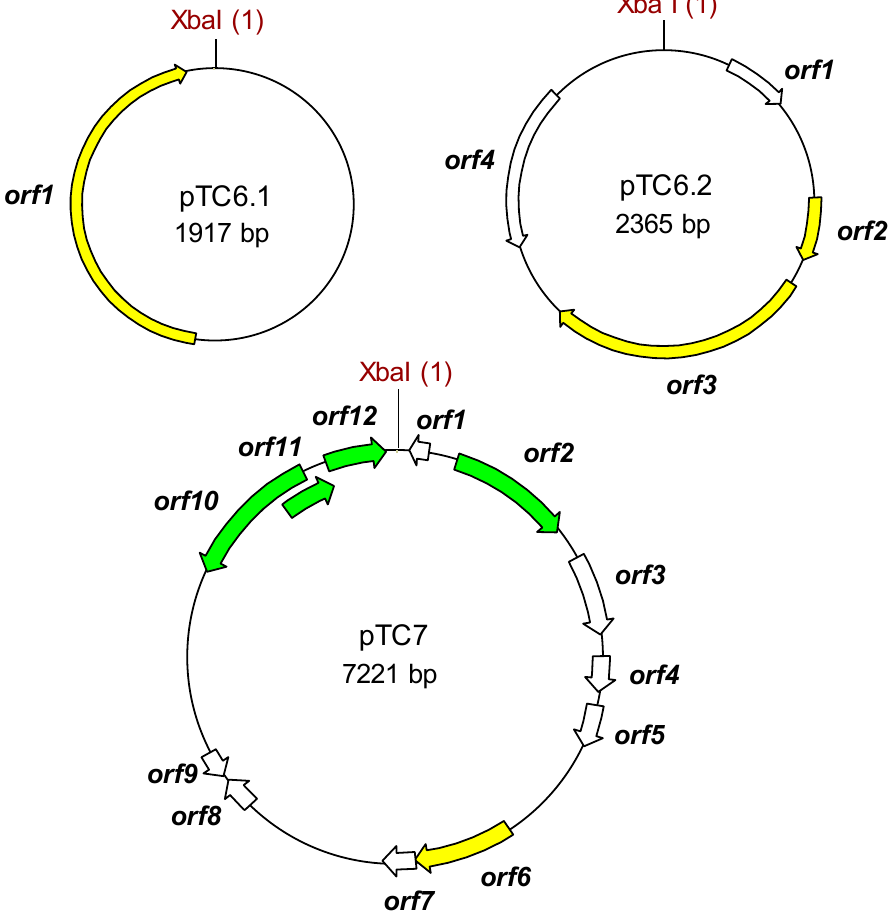
Figure 3. Drawn to scale genetic maps of the tetracycline resistance plasmids recovered in Lacticaseibacillus casei (pTC6.1, pTC6.2) and Lactiplantibacillus plantarum (pTC7). Plasmid features as in Figure 2.